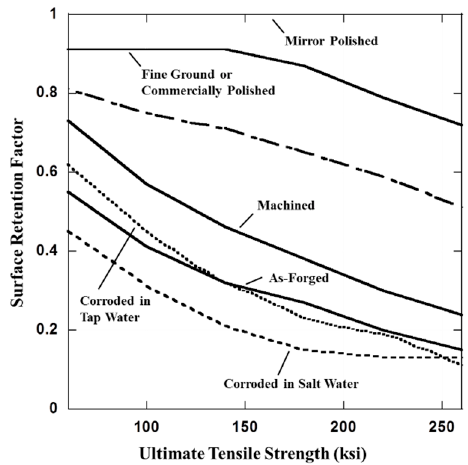
Figure 5. Surface finish effects on fatigue endurance limit [16].